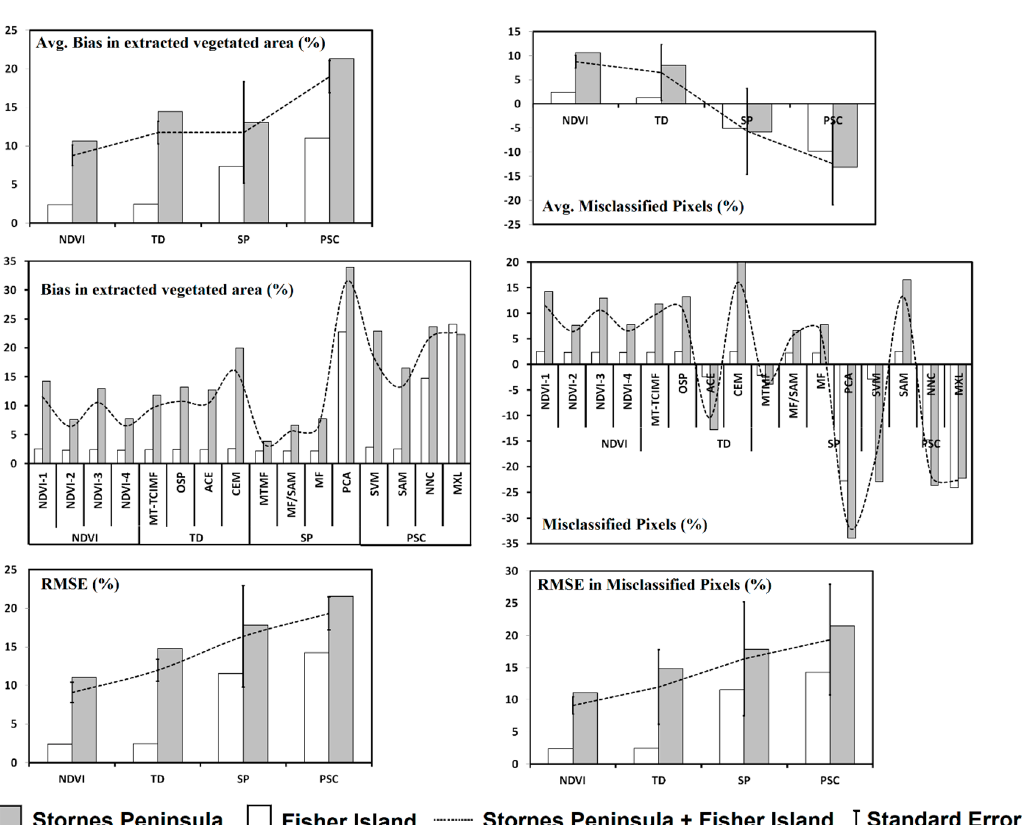
Figure 7. The overall performance trend for all vegetation extraction methods grouped in three approaches [Target detection (TD), Spectral processing approach (SP), and pixel-wise supervised classification approach (PSC)], in terms of misclassified vegetated pixels (%) with reference to vegetated pixels. Bias and RMSE values are expressed as